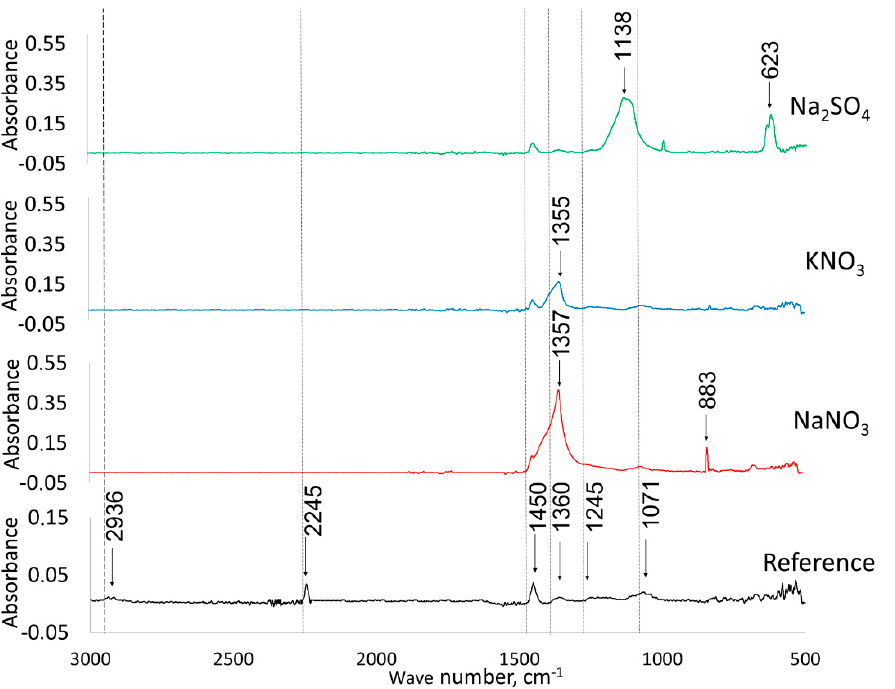
Figure 3. FTIR spectra of PAN/DMF fibre (reference) and the fibres soaked in aqueous 1.0 M elec- electrolytes: Na 2 SO 4 -H 2 O, KNO 3 -H 2 O, KNO 3 -H 2 trolytes: Na 2 SO 4 -H 2 O, KNO 3 -H 2 O, KNO 3 -H 2 O.